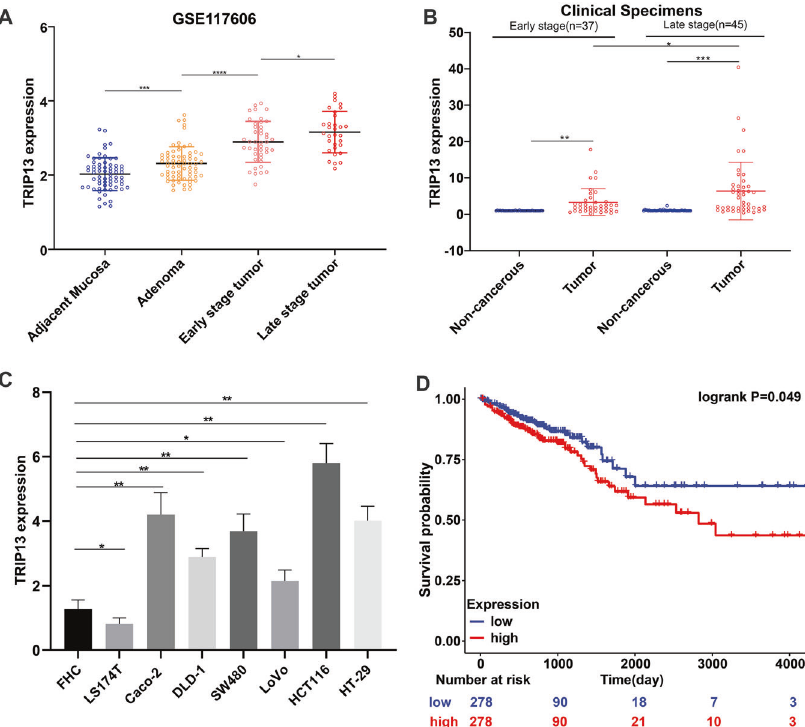
Fig. 3 Independent validation of TRIP13 expression in GSE117606, clinical specimens, and CRC cell lines. A TRIP13 expression of adjacent mucosa, adenoma, early stage tumor, and late stage tumor tissues in GSE117606 dataset. B TRIP13 mRNA expression was drastically increased in CRC tumor. Compared to the early stage, TRIP13 mRNA levels were signi fi cantly higher in the late stage tumor. C TRIP13 mRNA expression was signi fi cantly increased in CRC cells compared to FHC cells. D TRIP13 expression was correlated with survival of CRC patients. Low expression of TRIP13 conferred a survival advantage to CRC patients. * p < 0.05, ** p < 0.01, *** p < 0.001, **** p <